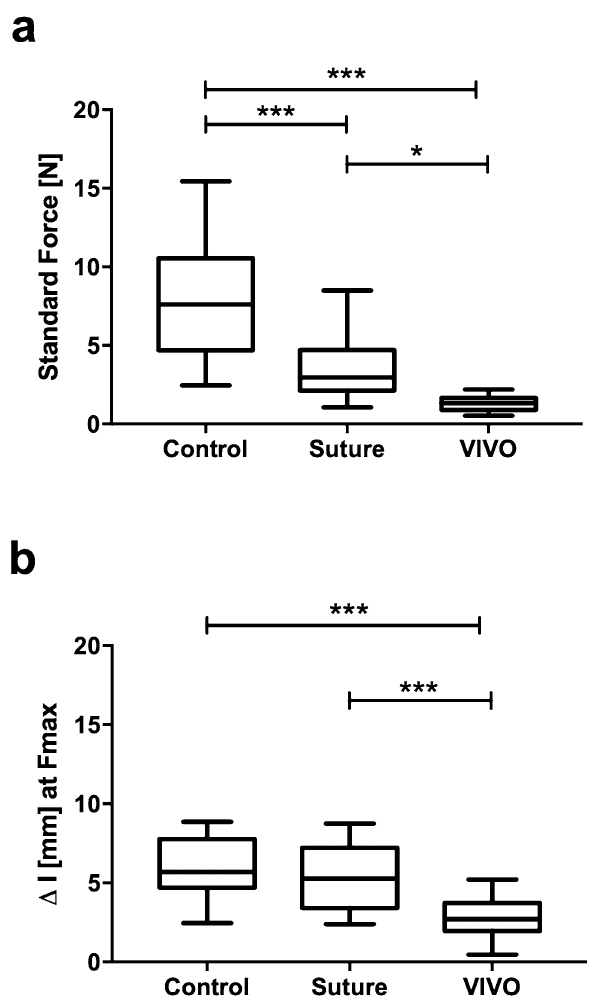
Figure 6. Box and whisker graphics of maximal tensile force and of Δl of all groups. The maximal tensile force of control vessels is the highest, followed by the Suture group ( a ). The comparison of Δl of all groups shows similar tendencies ( b ). ***p ≤ 0.001; *p ≤ 0.023. All scatter plots represent the means ±